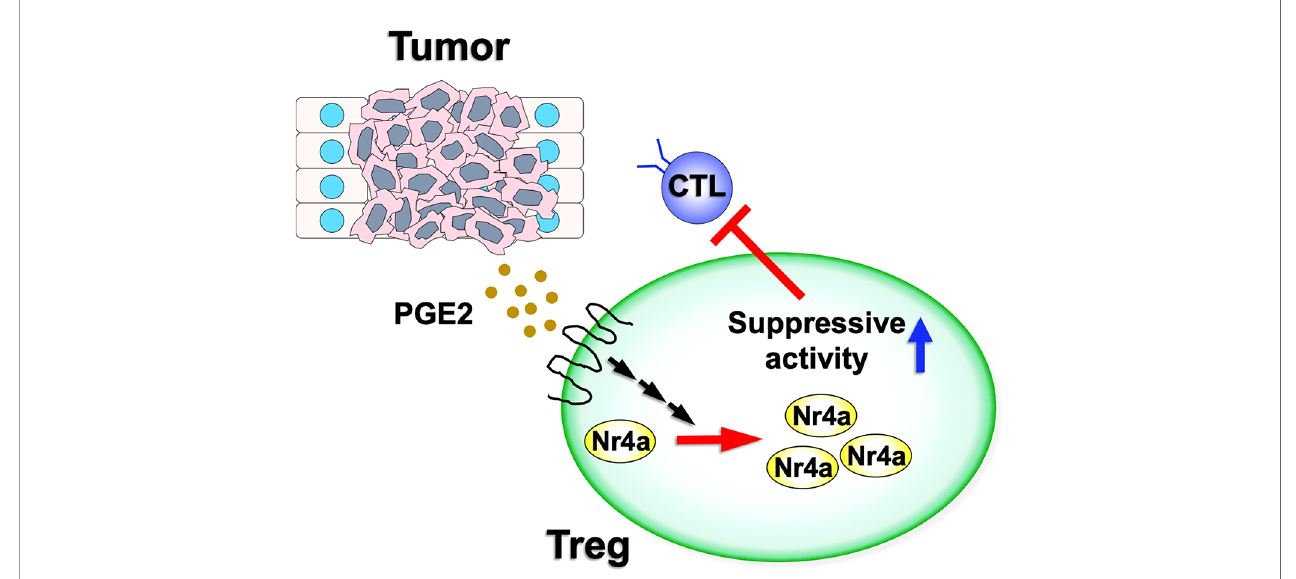
FIGURE 2 | Nr4a factor functions in tumor Treg cells. Various tumor microenvironments are enriched for PGE2. As PGE2 has the ability to upregulate both Nr4a1 and Nr4a2, this increased PGE2 expression may augment Nr4a factor activity and increase the suppressive activity of the Treg cells on antitumor